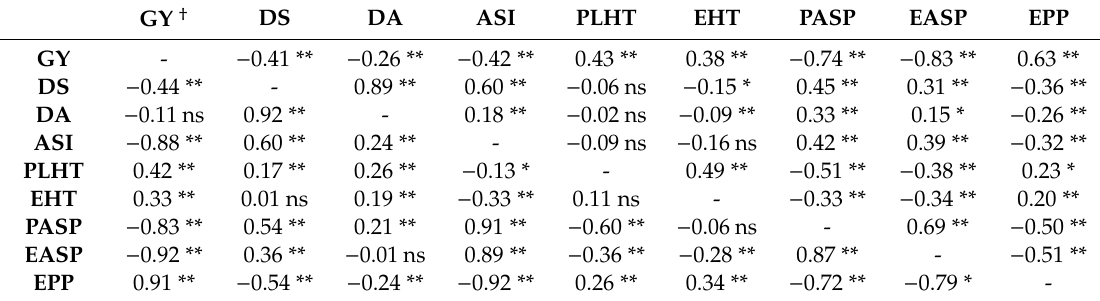
Table 6. Phenotypic (above diagonal) and genotypic (below diagonal) correlation coe ffi cients between grain yield and secondary traits † under managed drought at Ikenne during 2013 and 2014 dry